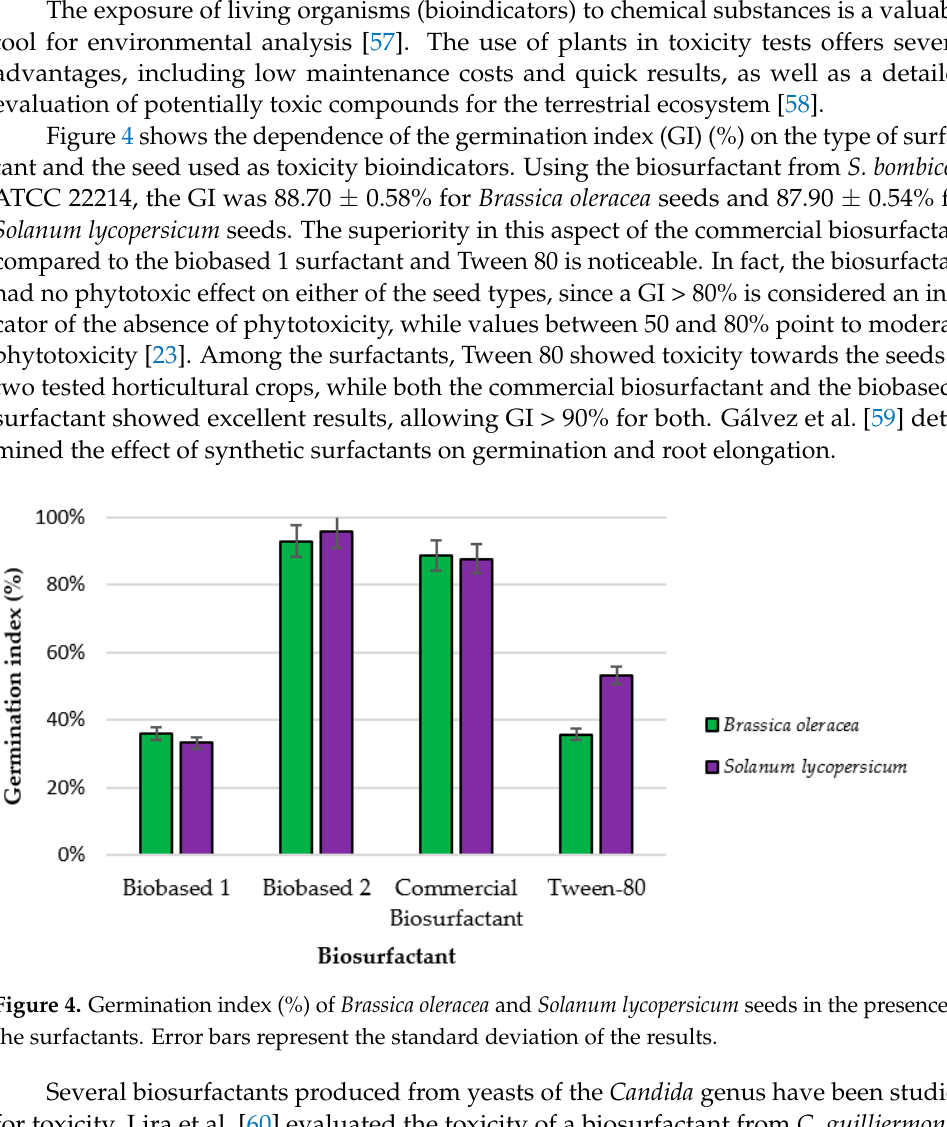
Table 5. Granulometry, consistency, and unified classification of soils. Parameters